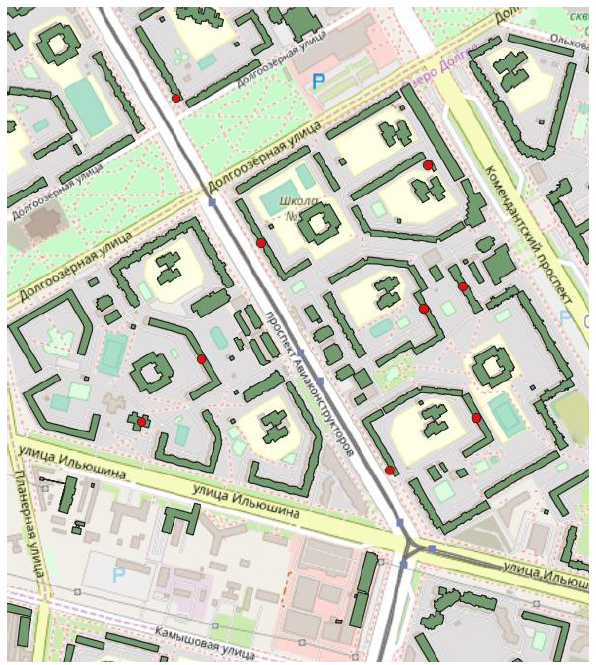
Figure 3. Geocoded map layers of point (red markers) and area (green polygons) geometry